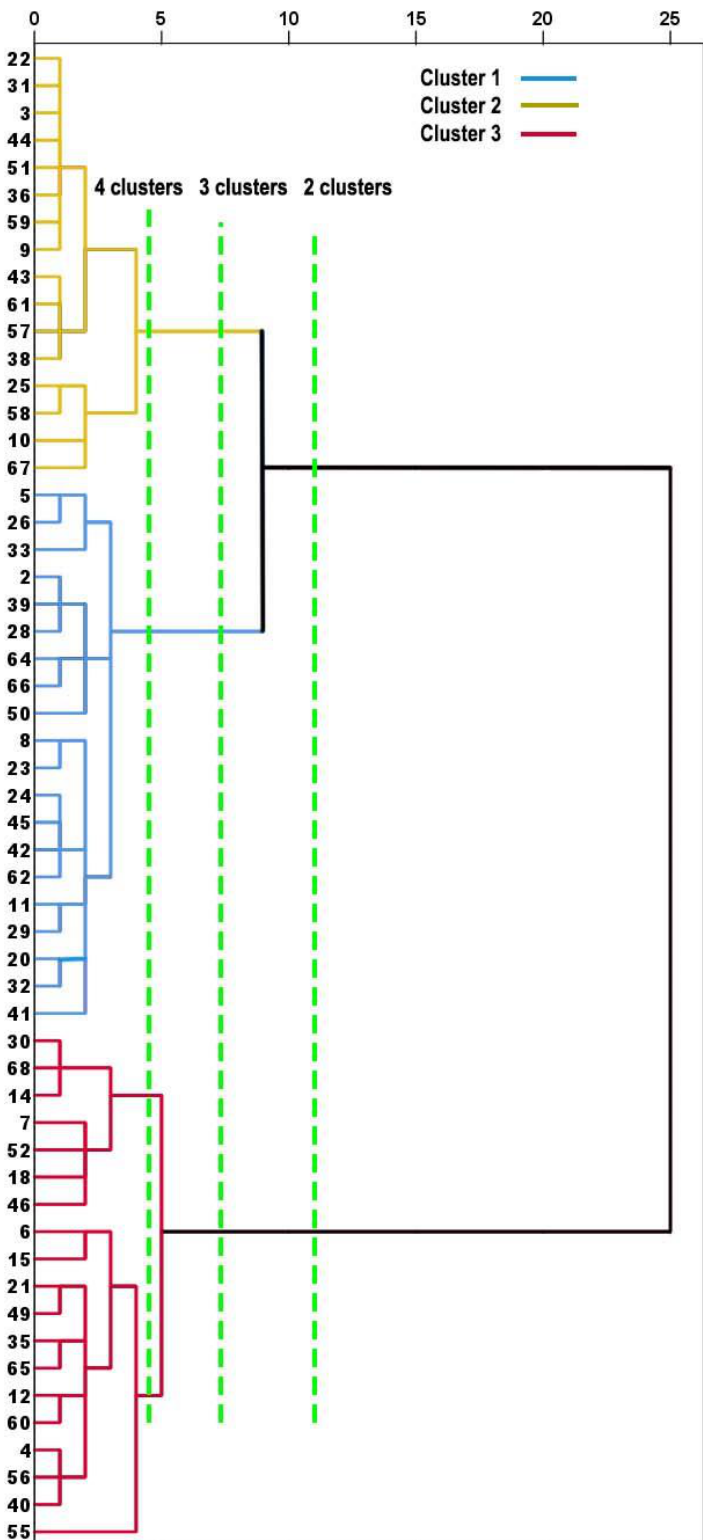
Figure 1. Dendrogram depicting hierarchical agglomerative clustering with Ward's linkage into 2, 3, or 4 cluster solutions. The three-cluster solution is color coded.